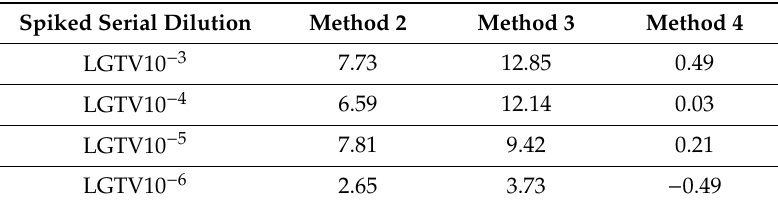
Table 2. The fold di ff erence observed for the initial methods evaluated in reference to the standard control Method 1. LGTV = Langat virus.